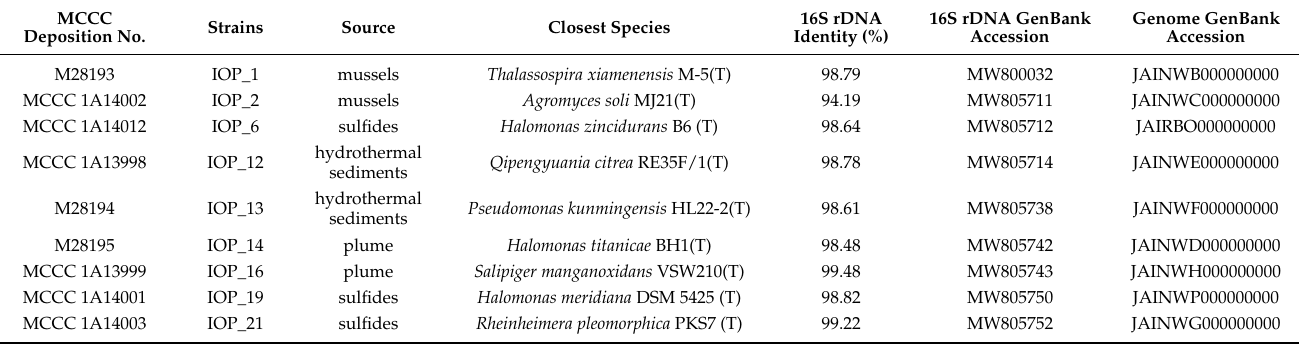
Table 1. GenBank accession numbers of 16S rRNA genes and genomes for isolates in this